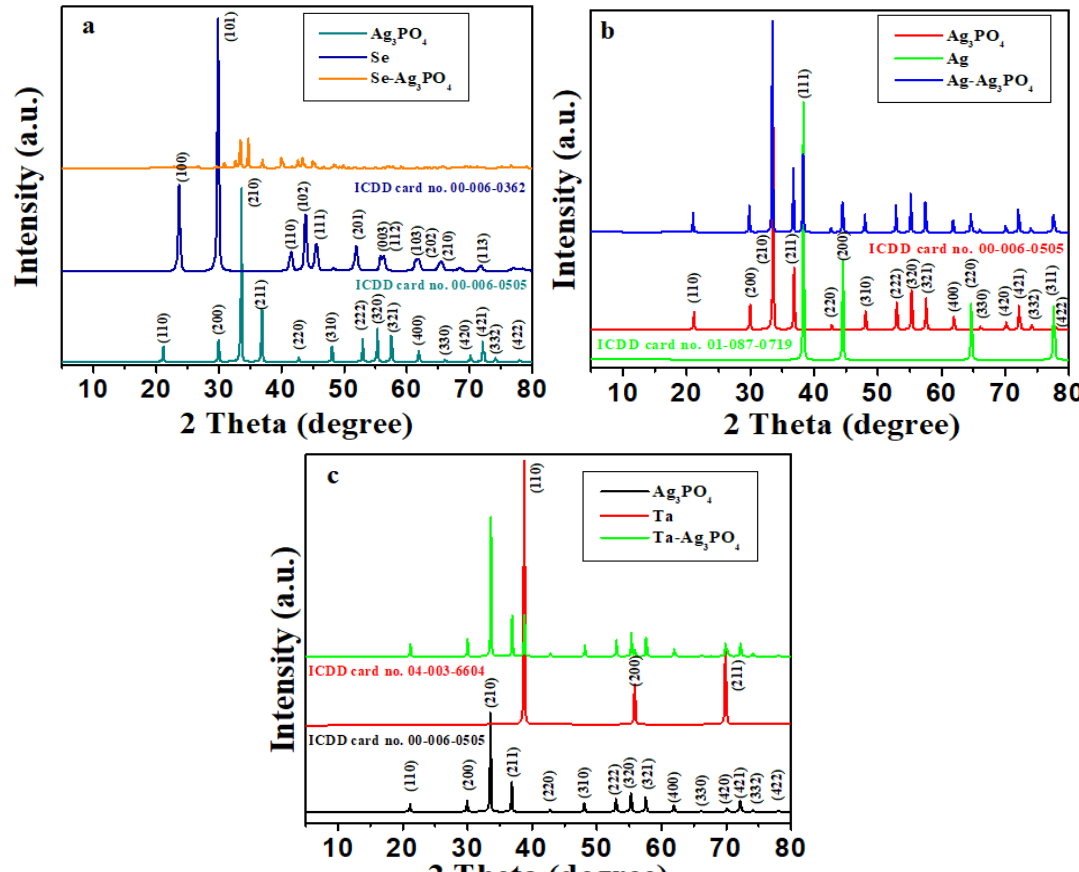
Figure 1. XRD pattern of Se-Ag 3 PO 4 ( a ), Ag-Ag 3 PO 4 ( b ), and Ta-Ag 3 PO 4 ( c ).